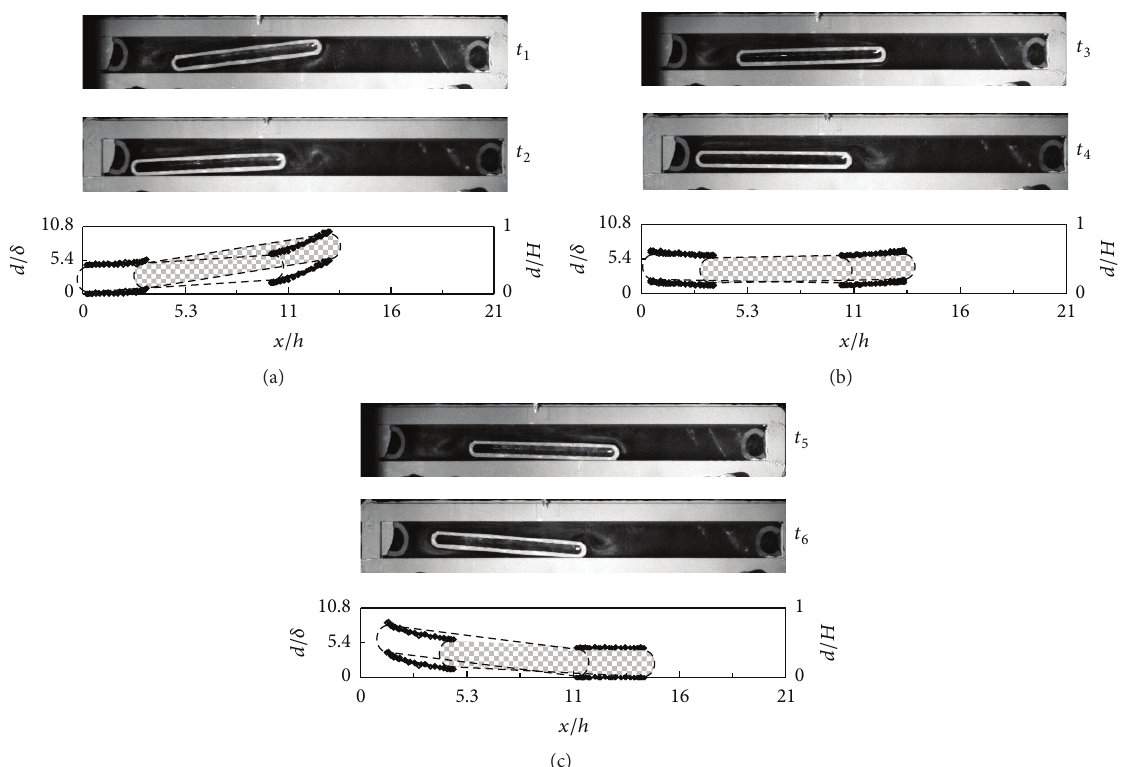
Figure 13: The oscillating body motion trajectory at different times during transition process near the left container end; time moments ( 𝑡 1 – 𝑡 6 ) are marked in Figure 12.